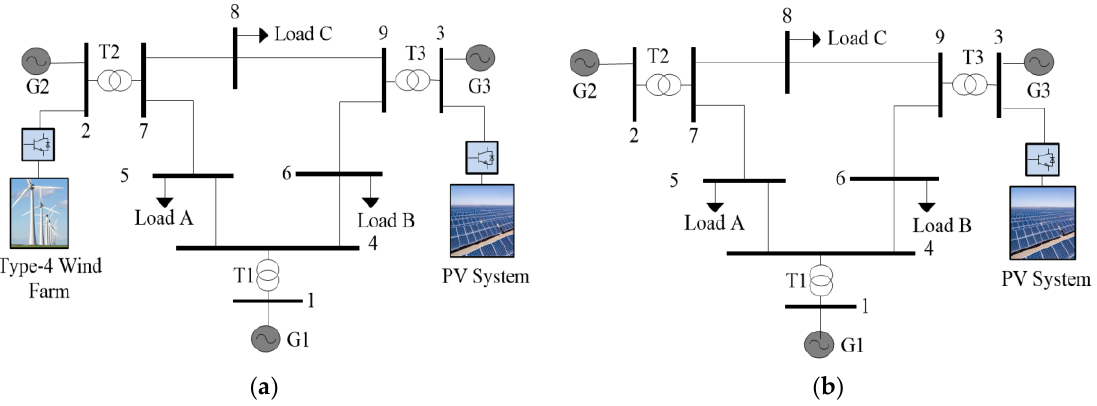
Figure 4. Modified IEEE nine-bus test system with RESs: ( a ) 22% RES penetration scenario ( b ) 56% RES penetration scenario.